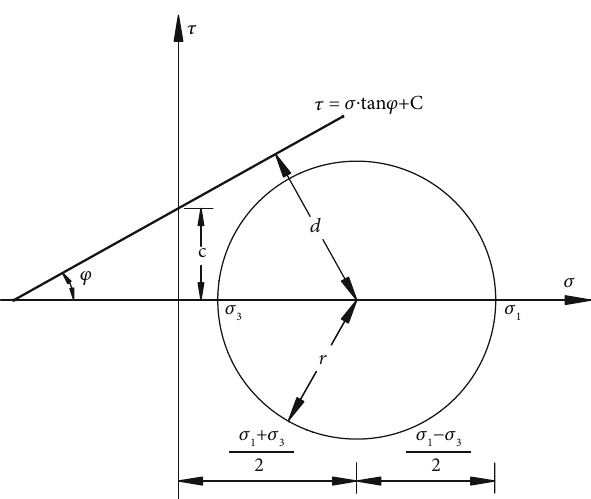
Figure 12: Percentage of triaxial compression units.